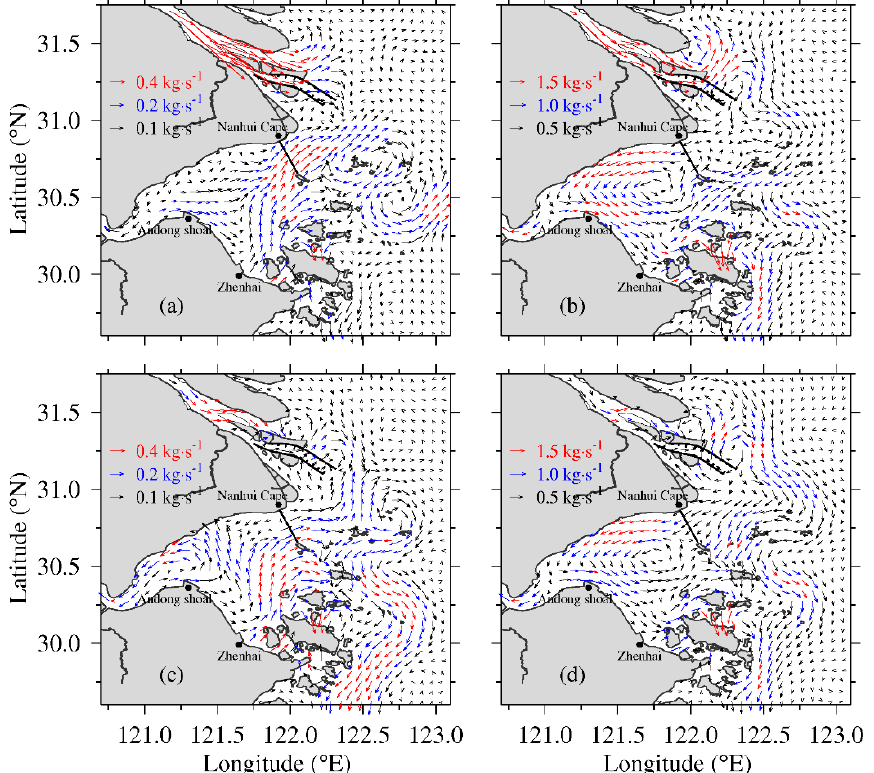
Figure 13. Distribution of the RUSF in the whole layer during neap tide (left panel) and spring tide (right panel) in summer ( a , b ) and winter ( c , d ); thick black line: section from Nanhui Cape to Qiqu Archipelago.